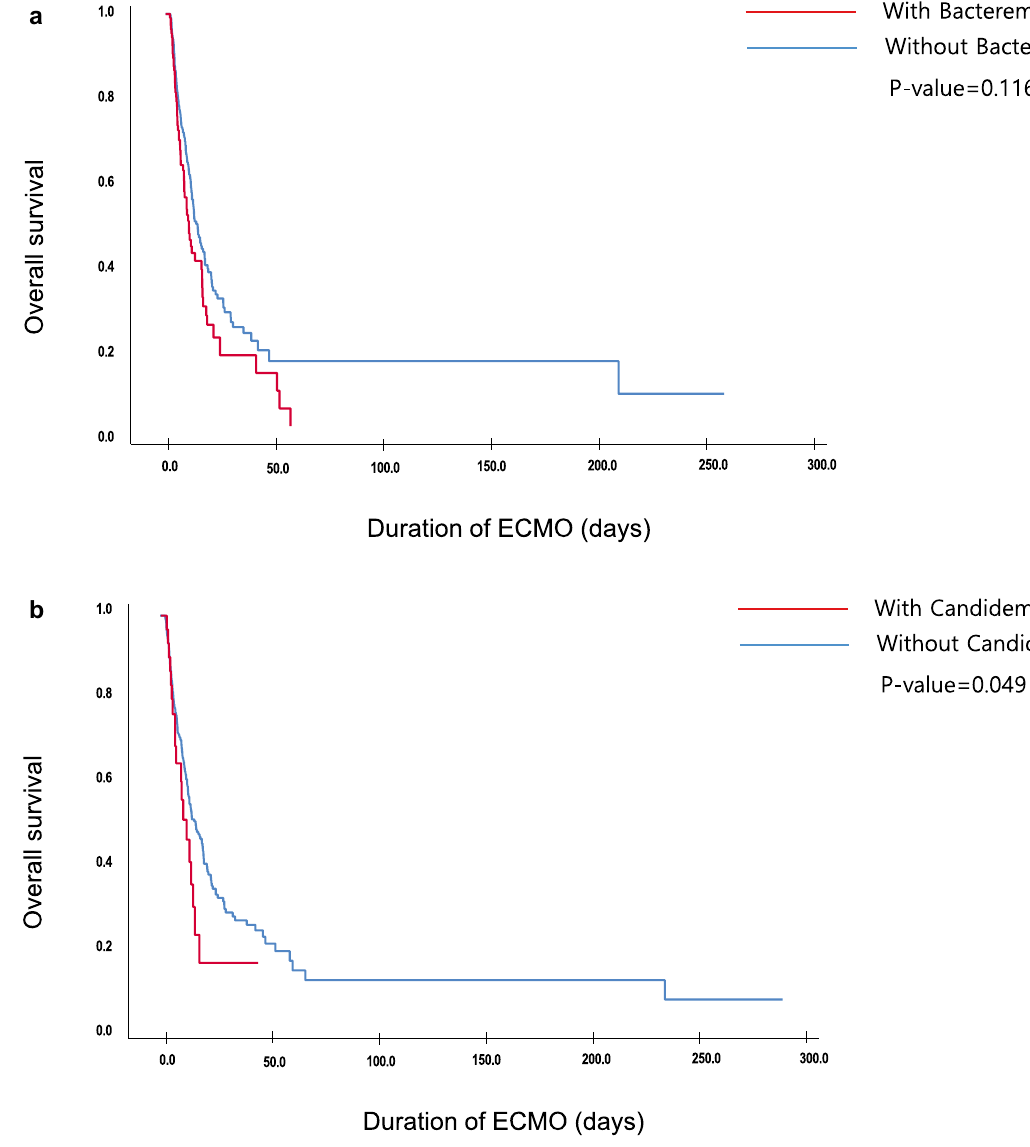
Figure 2. ( a ) Kaplan–Meier curve for non-BSI vs. Bacteremia group. BSI bloodstream infection, ECMO extracorporeal membrane oxygenation. ( b ) Kaplan–Meier curve for non-BSI vs. Candidemia group. BSI bloodstream infection, ECMO extracorporeal membrane